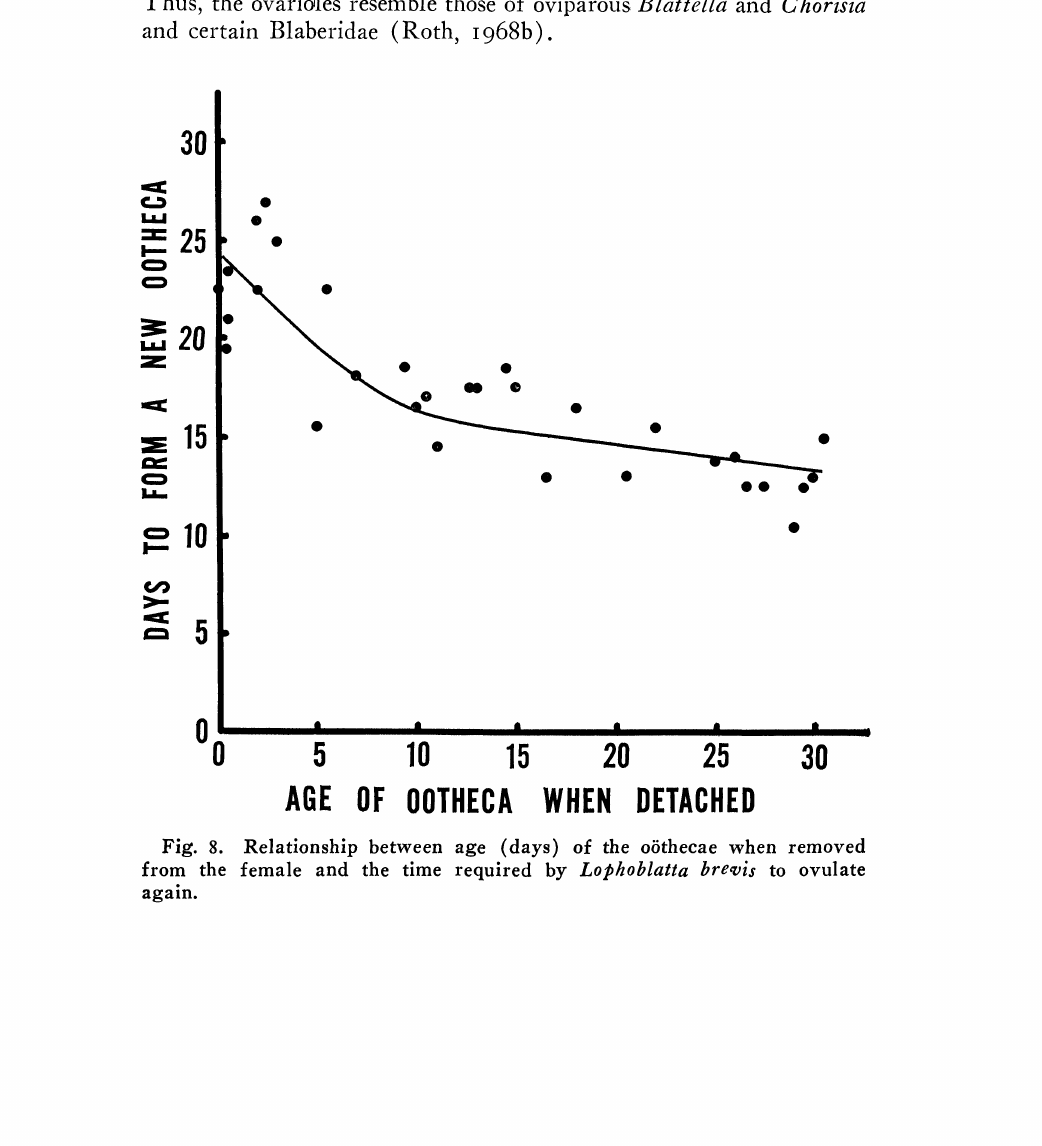
Fig. 8. Relationship between age (days) of the o6thecae when removed from the female and the time required by Lophoblatta bre,is to ovulate